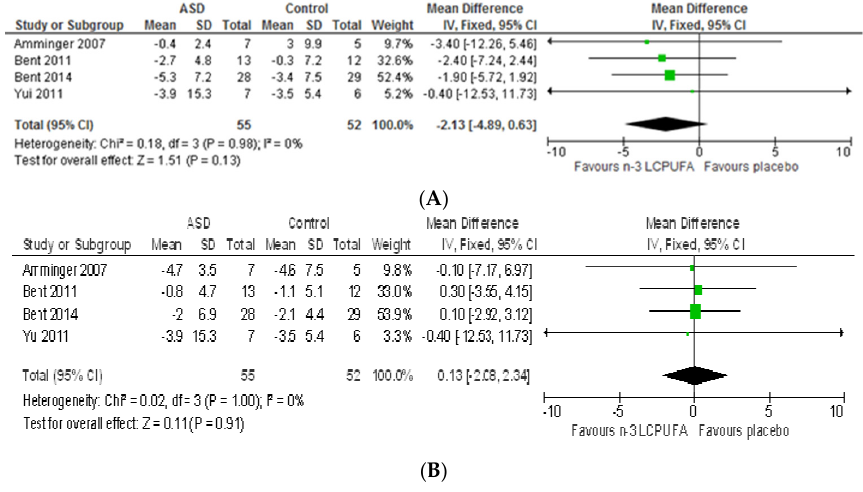
Figure 7. Forest plot of mean (95% confidence interval (CI)) fixed difference in change in hyperactivity (ABC) ( A ) and irritability (ABC) ( B ) in populations with Autism Spectrum Disorder (ASD) receiving n ‐ 3 long chain polyunsaturated fatty acid supplementation ( n ‐ 3 LCPUFA) and placebo. Direction of effect (negative, more improvement in n ‐ 3 LCPUFA group; positive, more improvement in placebo group; zero, no difference between groups).